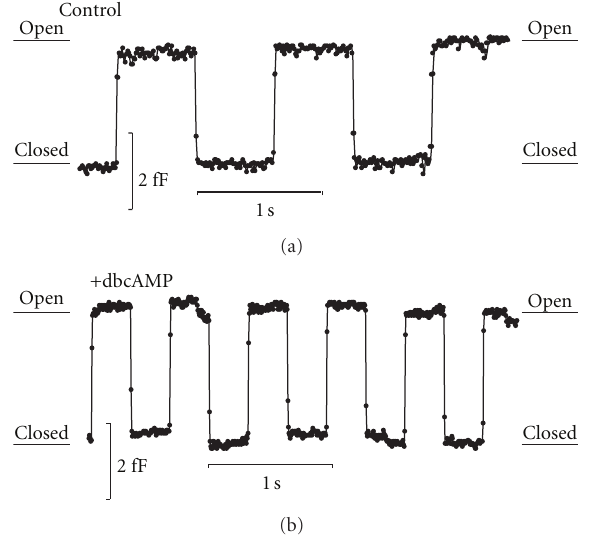
Figure 2: The application of a cAMP increasing agent increases the rhythmic openings and closures of an individual fusion pore, recorded in resting lactotrophs. Membrane capacitance recordings demonstrate the e ff ects of a cAMP increasing agent (dbcAMP, 10mM) (b) in comparison to the control experiment (a). The capa- citance trace demonstrates changes between low and high states, corresponding to e ff ectively closed and open fusion pore